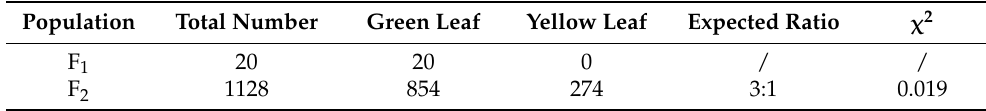
Table 1. Segregation analysis of leaf color in F 2 population.